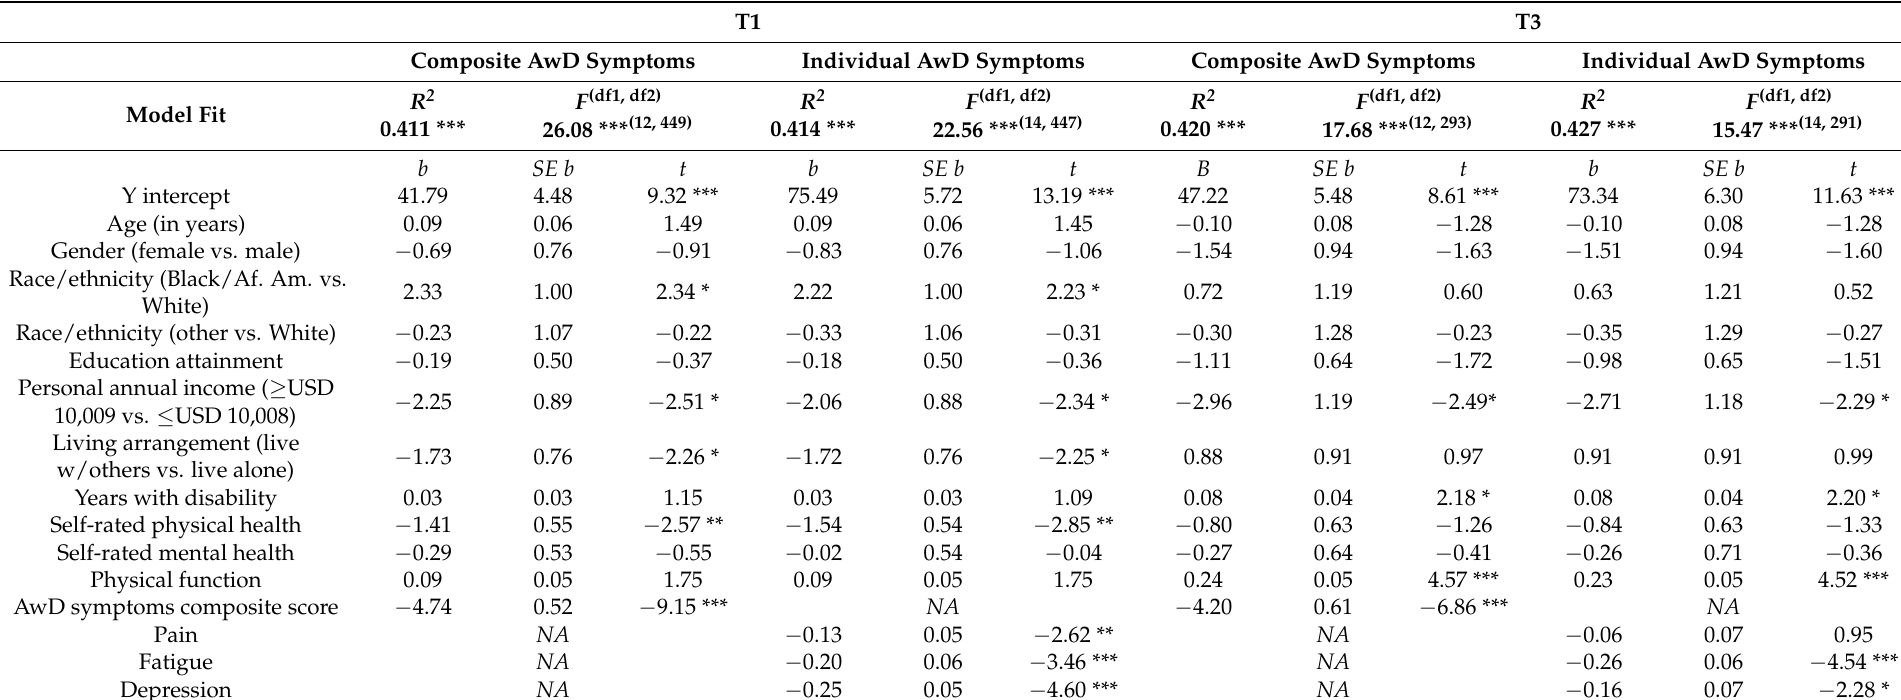
Table 4. Multivariate regression for satisfaction with social roles and activities at T1 and T3: AwD symptoms model comparisons. T1 T3 Composite AwD Symptoms Individual AwD Symptoms Composite AwD